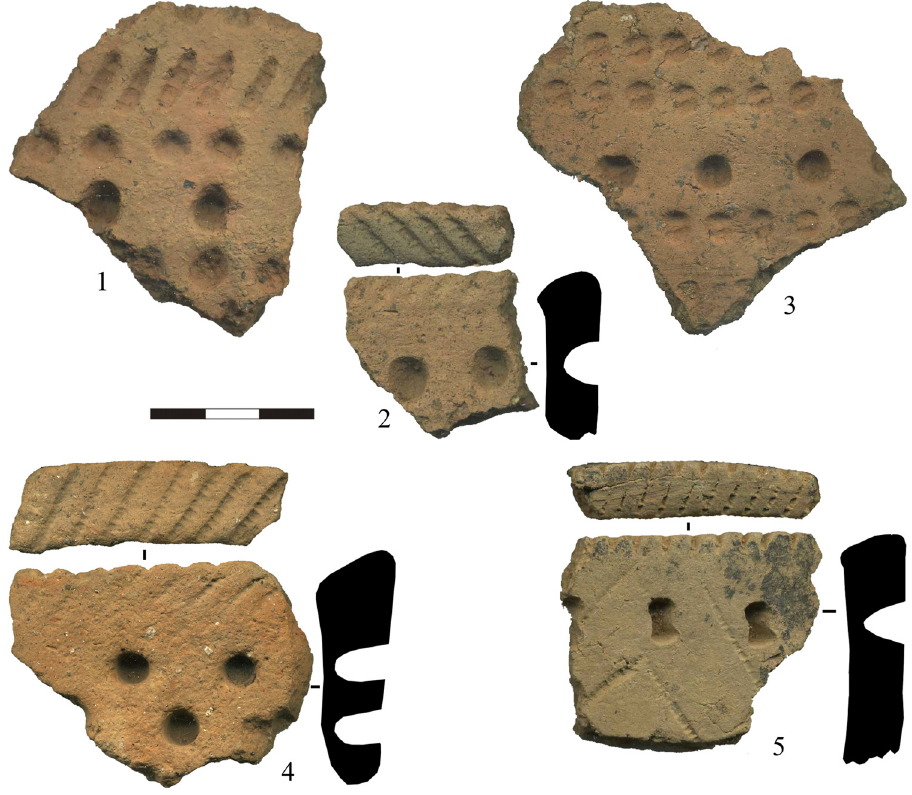
Figure 4: Typical Combed Ware from EGF: ( 1 – 3 ) Narva - Luga Klint Bay area ( Izvoz 3, MAE RAS ) ; ( 4 and 5 ) Karelian Isthmus ( Komsomolskoye 3, MAE RAS )